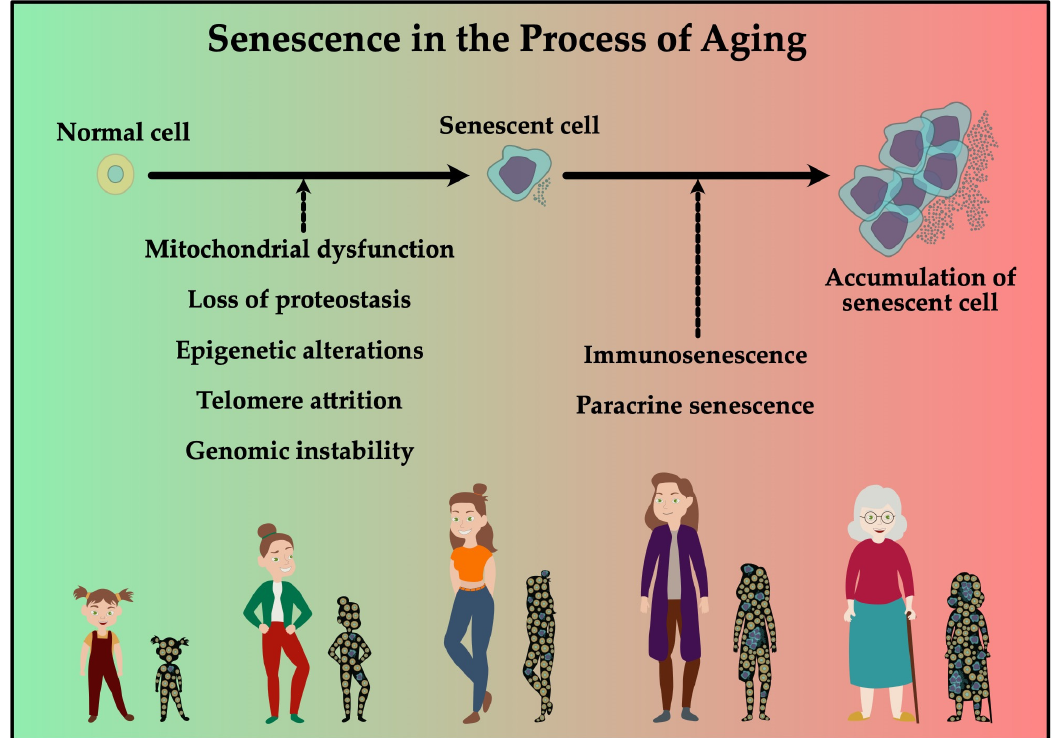
Figure 3. Normal cells can be induced to become senescent, which can induce paracrine senescence. Together with a decline in immune function, this could induce accumulation of senescent cells. In the elderly this accumulation contributes to increased risk in developing age ‐ related diseases.